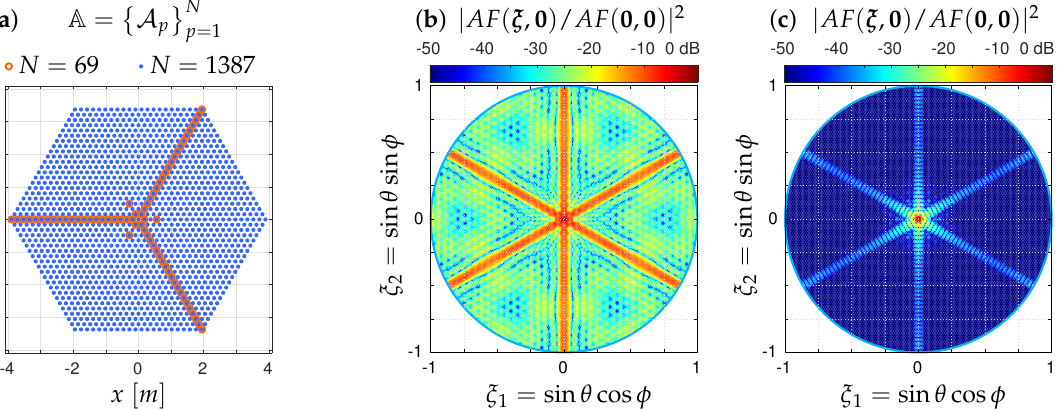
Figure 2. Impact of the sparsity of antenna arrays on the array factor with ( a ) the Y-shaped array of SMOS populated with 69 elementary antennas (orange) and a dense hexagonal array with the same dimensions but filled with 1387 elementary antennas (blue). As a consequence of the sparsity of the antenna array of SMOS, the corresponding array factor ( b ) exhibits side-lobes as high as − 7.2 dB in the 6 tails of | AF ( ξ , 0 ) | 2 ) and it has a main beam as large as 0.0355 rad at half-power. On the contrary, the array factor of the dense hexagonal array ( c ) exhibits side-lobes as low as − 19 dB in the 6 tails of | AF ( ξ , 0 ) | 2 ) and it has a main beam as narrow as 0.0299 rad at half-power. For ease of comparison, array factors are here normalized and the same color scale is used.